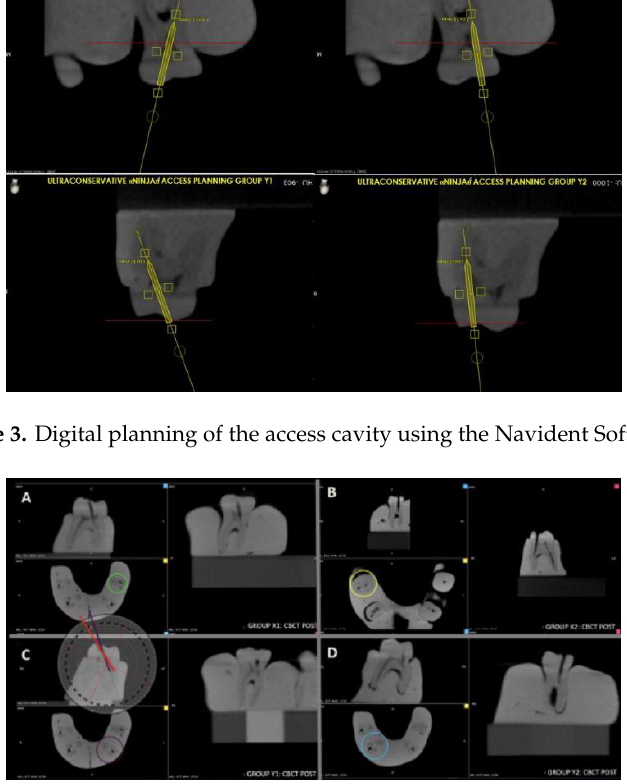
Figure 4. Buccal, mesial and occlusal views of X1 ( A ), X2 ( B ), Y1 ( C ), Y2 ( D ) group: example cases. In (C) is shown how inclination angle was measured.